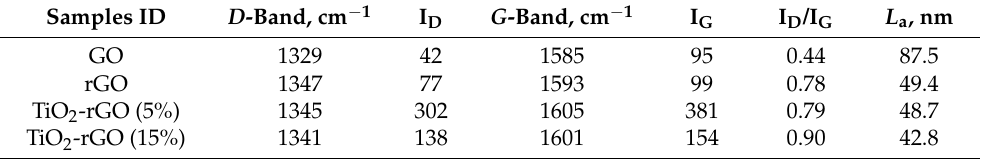
Table 1. Raman intensity and shift of the prepared GO, rGO, and TiO 2 @rGO nanocomposites. Samples